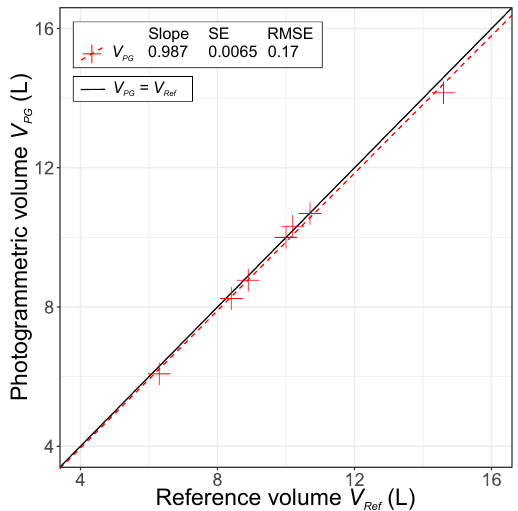
Figure 2. Validation of the photogrammetry method (PG) by esti- mating the volumes of seven irregularly shaped rocks with similar volumes to small termite mounds. The dashed line indicates the lin- ear regression between V PG and V Ref , with slope, standard error (SE) and root mean square error (RMSE); the black solid line de- notes perfect correlation.